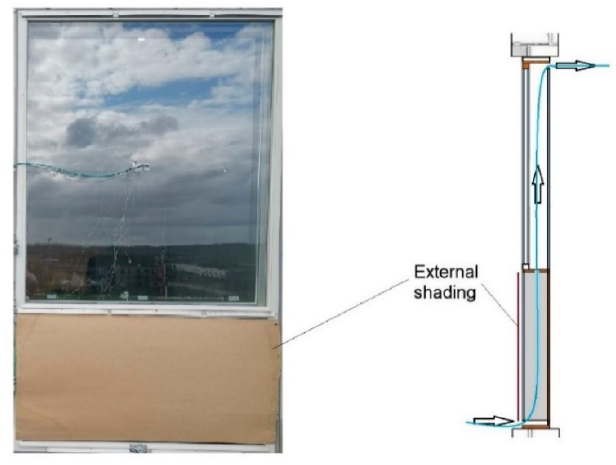
Figure 17. Outside view and components of the system proposed by Hu et al. [55].